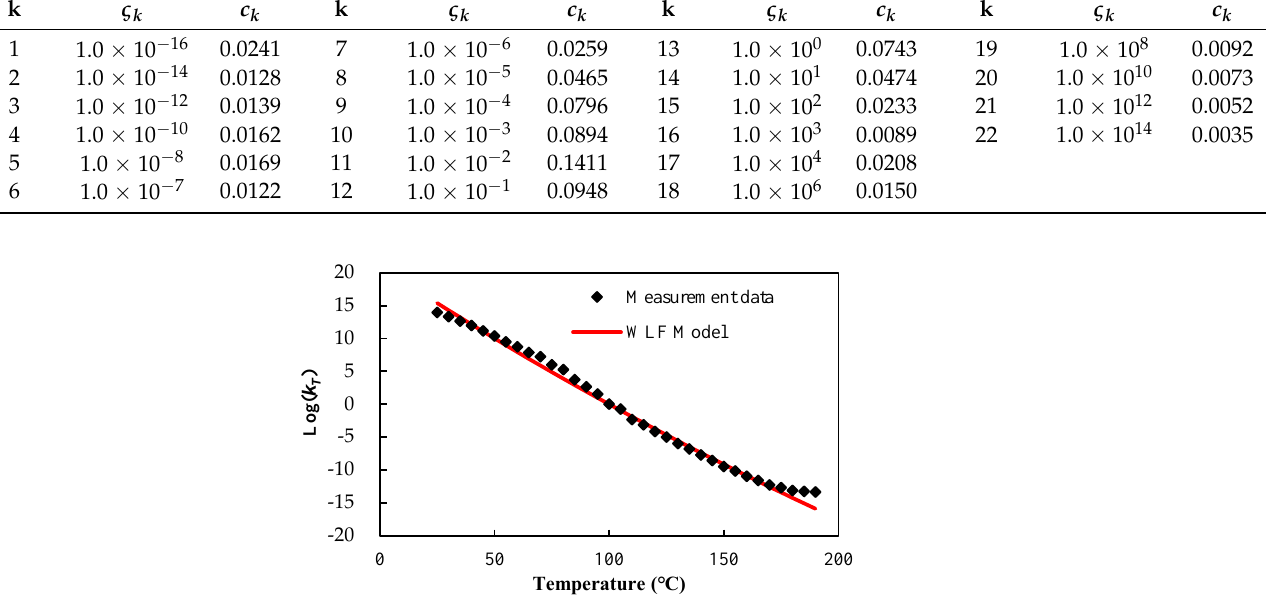
Figure 9. Temperature shift factors and WLF curve fitting.